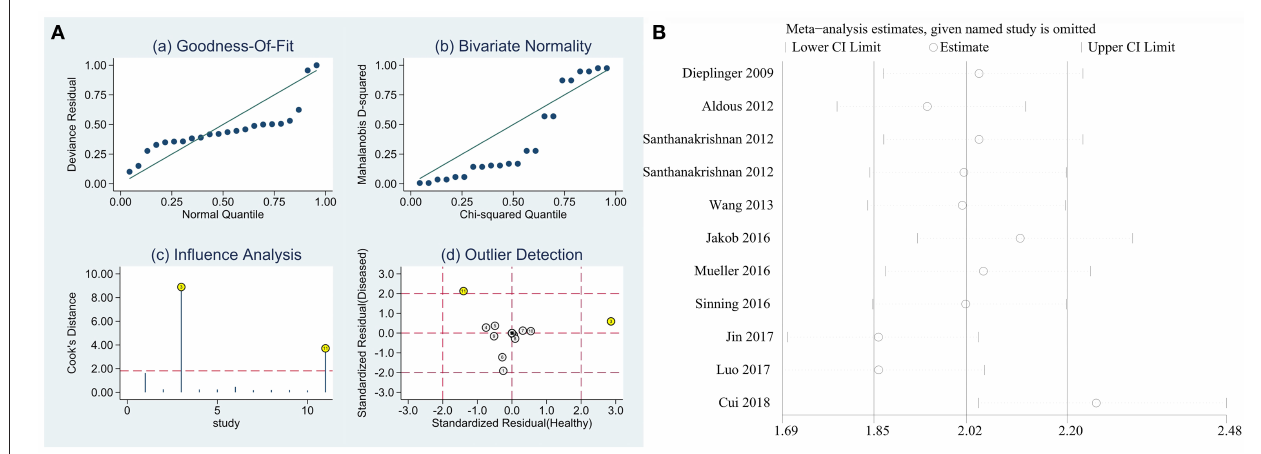
FIGURE 6 | Sensitivity analysis diagram. (A) Sensitivity analysis, (B) Individual study exclusion.